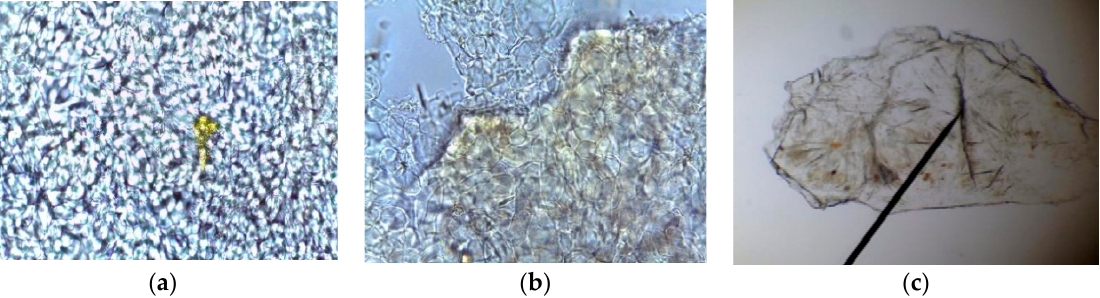
Figure 1. Microscopic characterization of Terfezia claveryi . ( a ) Epidermis cells; ( b ) Oil glands; ( c ) Sclereid-like structure in the peridium.